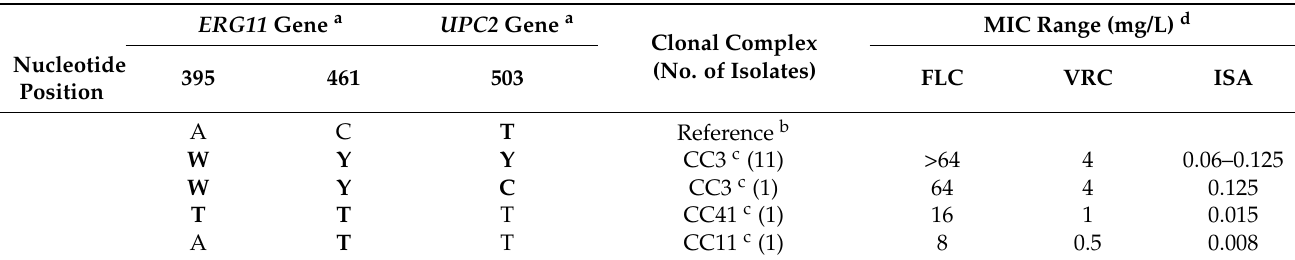
Table 3. Homozygote and heterozygote nonsynonymous mutations in ERG11 gene and UPC2 gene among 14 ERG11 non-wild-type Candida tropicalis isolates with azole MICs and corresponding clonal complexes. ERG11 Gene a UPC2 Gene a MIC Range (mg/L) Clonal Complex (No. of Isolates)